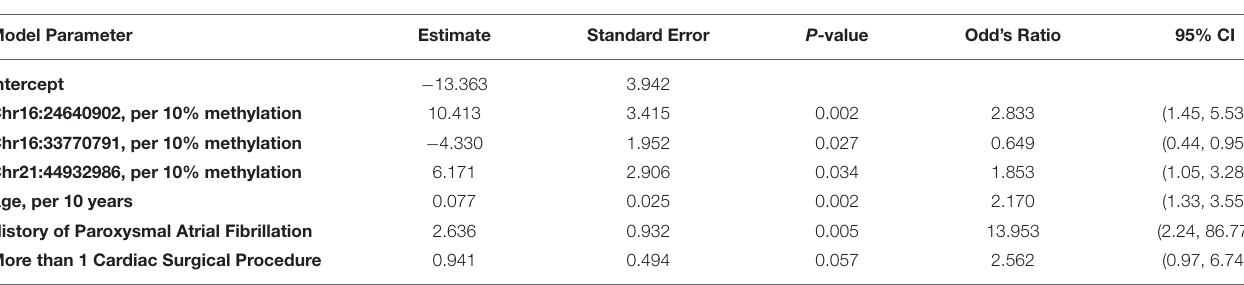
TABLE 3 | Methylation model for post-operative atrial fibrillation. Model